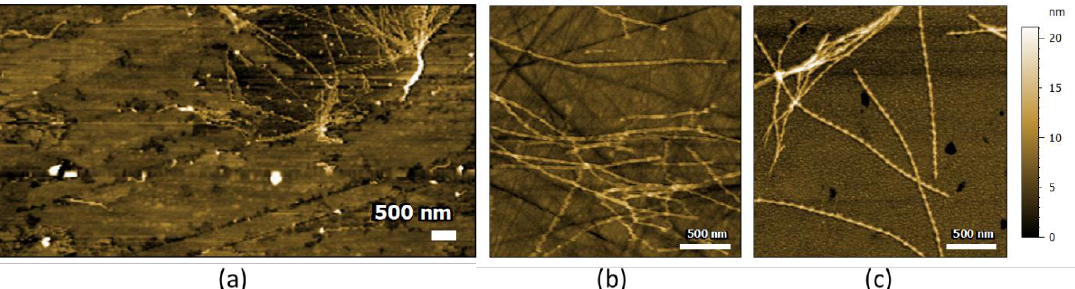
Figure 6. AFM images of α-synuclein fibrils on different substrates: ( a ) ZnSe prism, ( b ) ZnS prism and ( c ) Au substrate. We observed on the ZnSe prism amorphous aggregates with a few residual fibril-like structures on the top-right corner, and on all the other surfaces well-deposited long amyloid fibrils. We also acquired AFM-IR spectra for the α -syn fibrils on ZnSe and ZnS prisms. In Figure 7, the black curve represents the amyloid fibrils measured by ATR-FTIR used as a reference, and the red spectrum represents α -syn fibrils deposited on the ZnS prism. On ZnS, not only is the morphology − 1 conserved (Figure 6b), but also the IR spectrum, with a major band centered at 1628 cm as expected for amyloids. The blue curve was obtained on a ZnSe prism. The spectrum changes drastically. Two bands − 1 − 1 are present, the major one around 1660 cm and the second at 1630 cm . A large decrease in the β -sheet content due to a restructuring of the α -syn amyloid fibrils, similar to A β 42 fibrils, is therefore also induced by ZnSe. On the amide II band, we can observe a decrease in the maximum wavenumber, − 1 − 1 which is at 1550 cm for the fibrils on ZnS and at 1544 cm for restructured fibrils on the ZnSe; − 1 both spectra have a shoulder peak at 1536 cm .